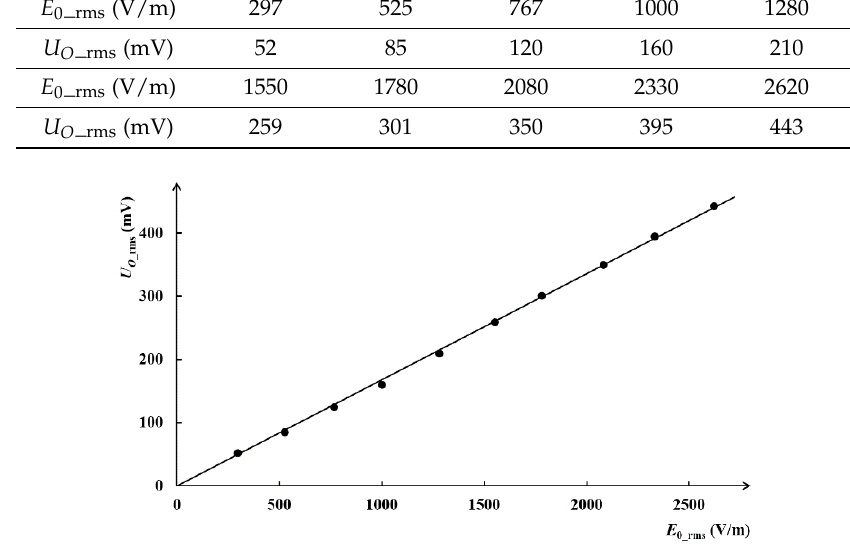
Figure 9. The measuring results and fitting curve.